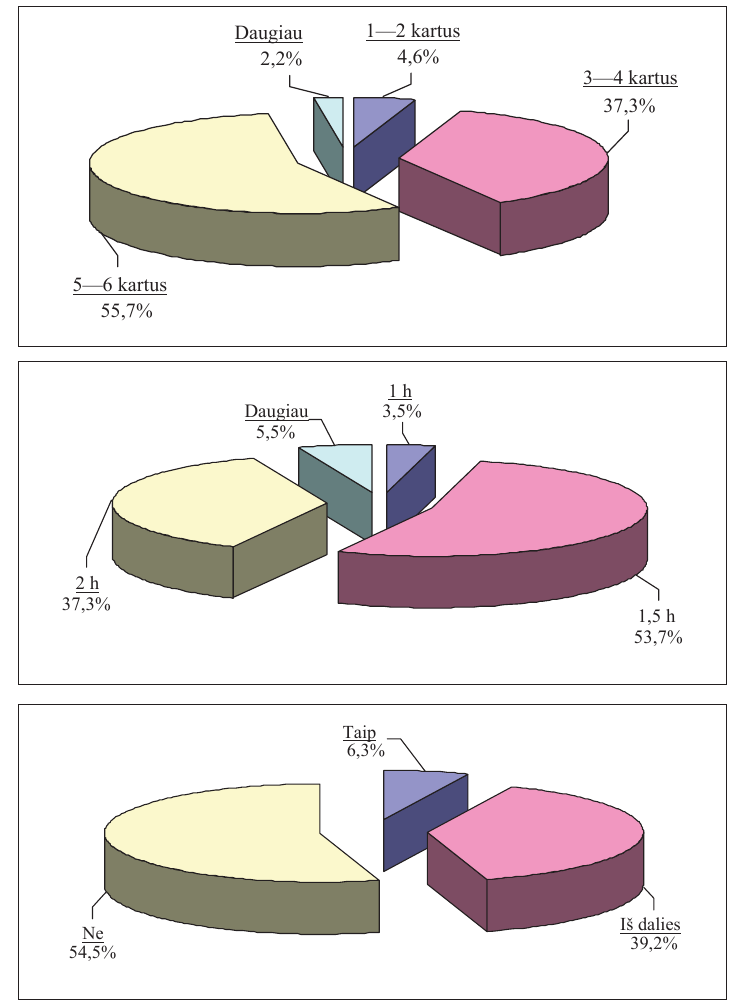
sportininkai daugiau dalyvauja varžybose ir nori